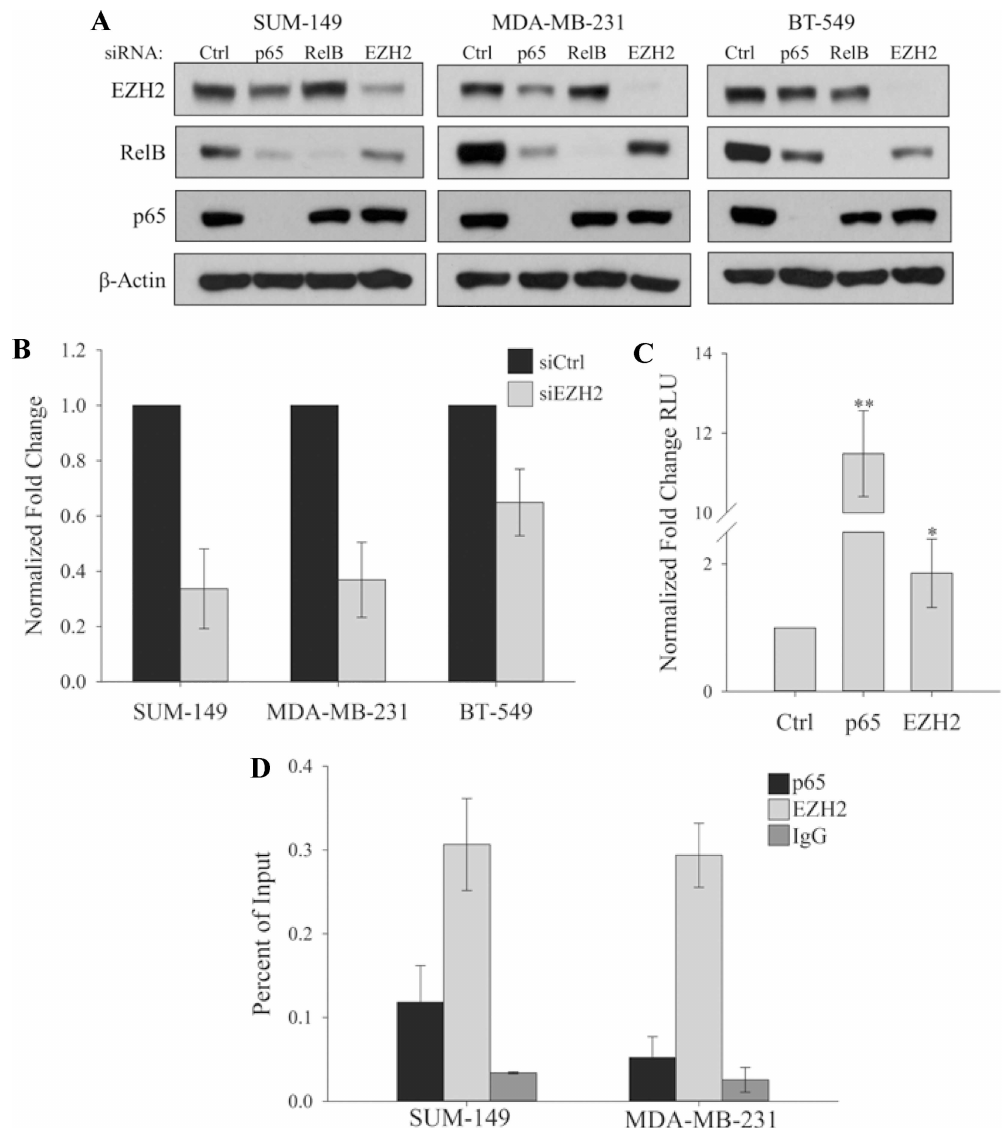
Fig 3. EZH2 is a transcriptional activator of RelB. (A) Immunoblots of indicatedproteinsin SUM-149,MDA-MB- 231 or BT-549cells expressing control siRNA or siRNA targetingp65, RelB or EZH2. β -actinserves as a loading control. (B) Real time PCR showingexpressionof RelBin SUM-149,MDA-MB-231 and BT-549cells. Expression was normalizedto glucuronidasebeta. Valuesgivenas means ± standard deviation from three biologicalrepeats. (C) Dualluciferaseassay from HEK293cells co-expressingthe RelB Reporterwith either Flag-p65or HA-EZH2 and Renillaluciferase. Relativelight units (RLU)was normalizedto Renillaluciferaselight units and expressed as fold over the RelBpromoteralone. Valuesgivenas means ± standard deviationof four biologicalrepeats. * P = 0.05, ** P < 0.05 versus controls; two tailed unpairedt-test. (D) ChIP analysisof p65 and EZH2 bindingat the RelB promoter in SUM-149 and MDA-MB-231 cells. Non-specific bindingwas estimated from IgG immunoprecipitates. Valuesgiven as means ± standarddeviationfrom three technicalrepeats of one representative experimentfrom the three